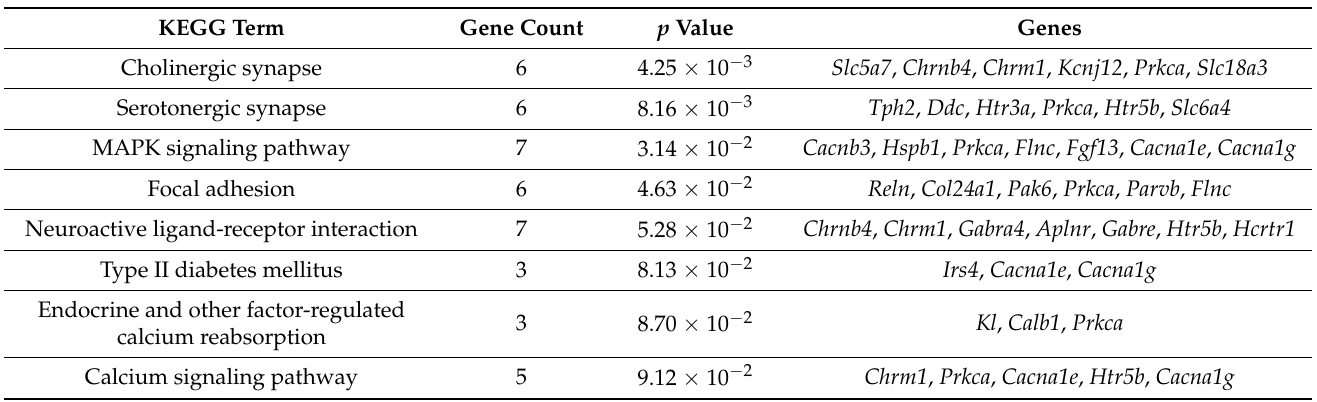
Table 2. KEGG terms most significantly related to the DEGs in the MRNs of the losers (defeated mice) compared to controls. KEGG Term Gene Count p Value Genes Cholinergic synapse 6 4.25 × 10 − 3 Slc5a7 , Chrnb4 , Chrm1 , Kcnj12 , Prkca , Slc18a3 Serotonergic synapse 6 8.16 × 10 − 3